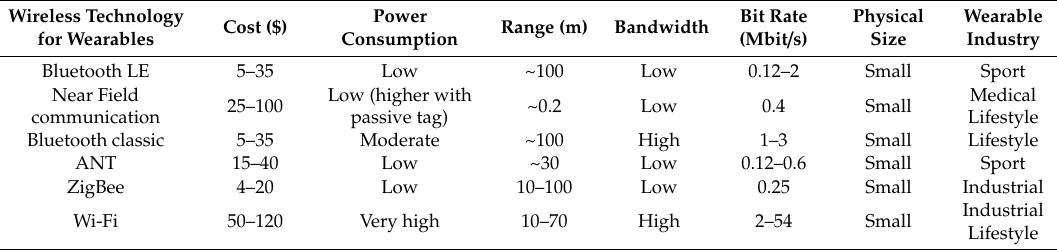
Table 2. Wireless technologies for wearables; data taken from their respective